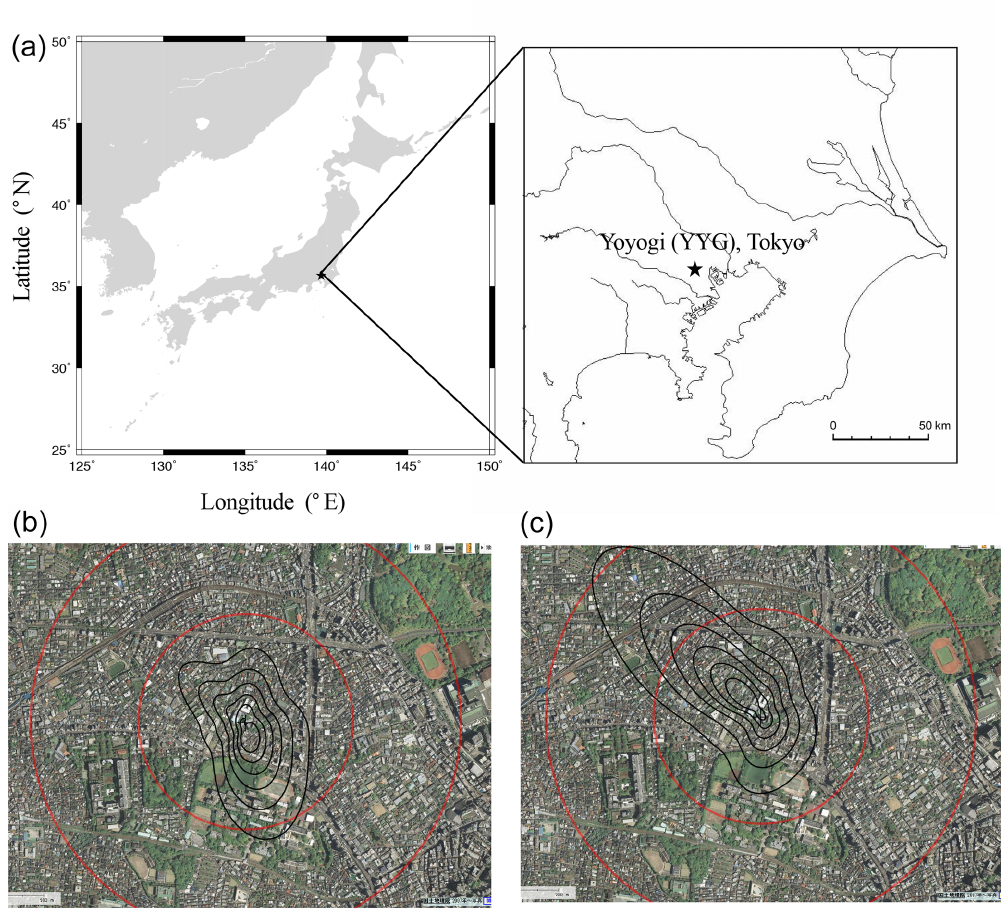
Figure 1. (a) Location of the Yoyogi site (35.66 ◦ N, 139.68 ◦ E, YYG), Tokyo, Japan. (b, c) Aerial photo from the Geospatial Information Authority of Japan around the study area at YYG. Ensemble-mean flux footprints in the summer (b) and winter (c) are also shown by black circles. The contour lines indicate contribution in measured flux (60%, 50%, 40%, 30%, 20% and 10% from outside to inside). Inside and outside the red circles indicate the distances of 500 and 1000m, respectively, from a roof-top tower of Tokai University where the observations of O 2 and CO 2 concentrations and CO 2 flux were carried